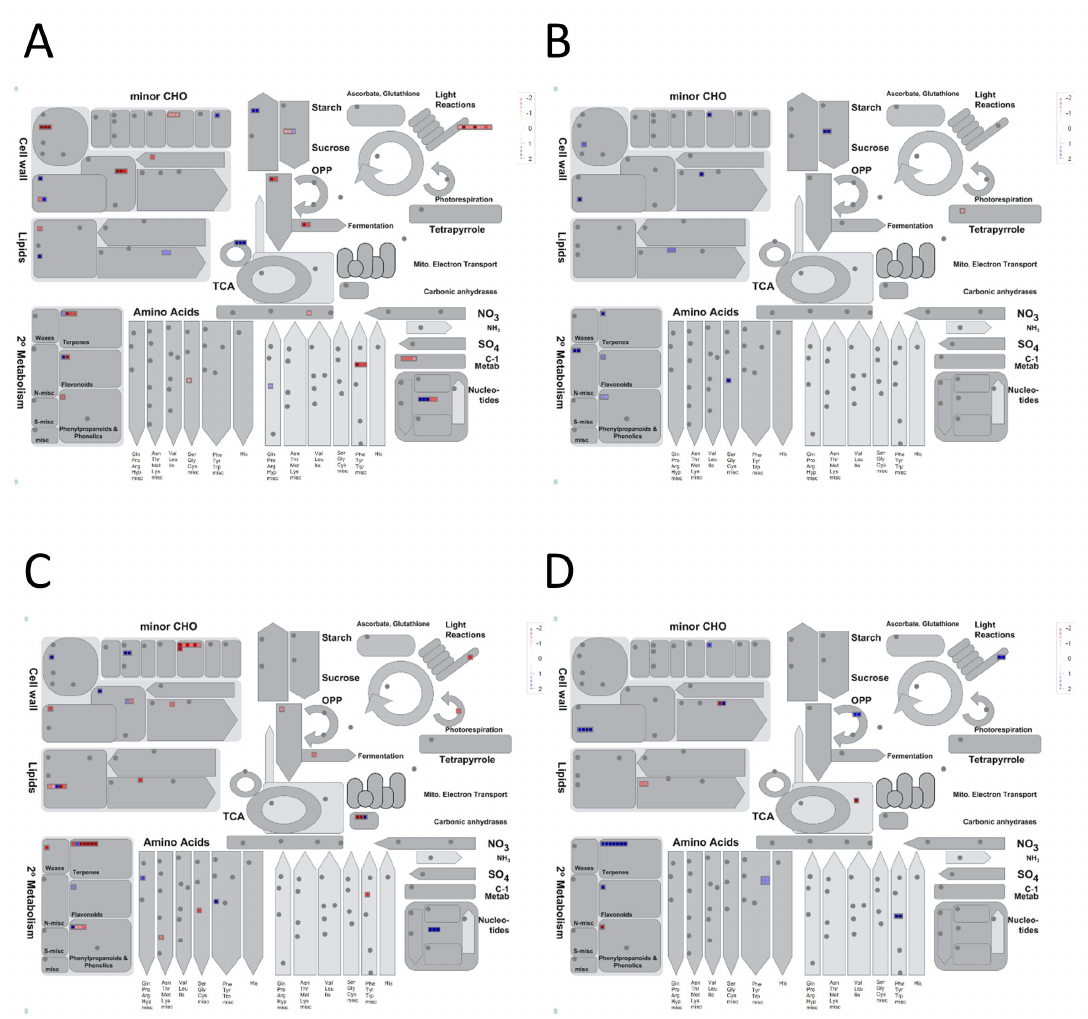
Figure 3. Mapman overview of the DEGs of interest in DTY-IL and Swarna under RDS. The metabolism overview in in the flag-leaf tissue for Swarna ( A ) and DTY-IL ( B ), as well as for the panicle tissue in Swarna ( C ) and DTY-IL ( D ). The DEGs were binned to the MapMan functional categories. The values are the log 2 fold changes. Upregulated categories are represented in blue and downregulated categories